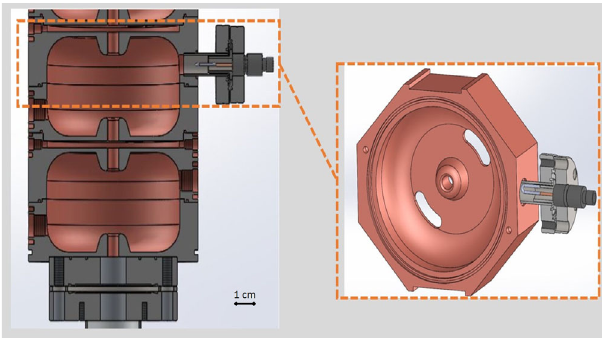
FIG. 6. Cavity with magnet loop for on-line measurements of the